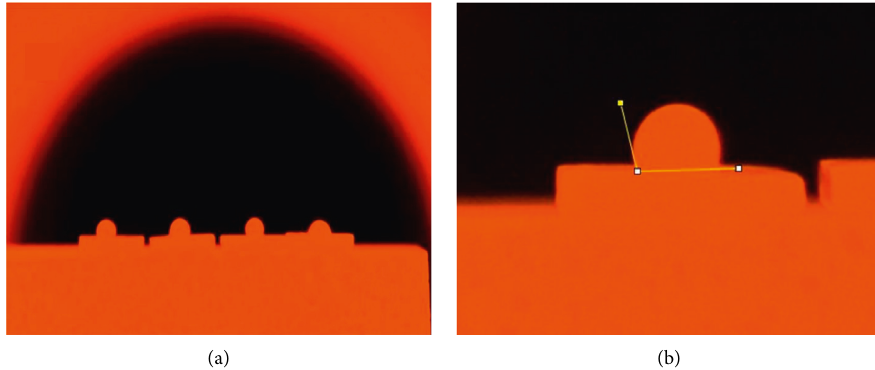
(a) (b) Figure 3: (a) Zirconia-veneering ceramic assemblies in the tube furnace; (b) contact angle measurement by drawing two tangent lines (yellow lines), one to the zirconia surface and another to the feldspathic ceramic